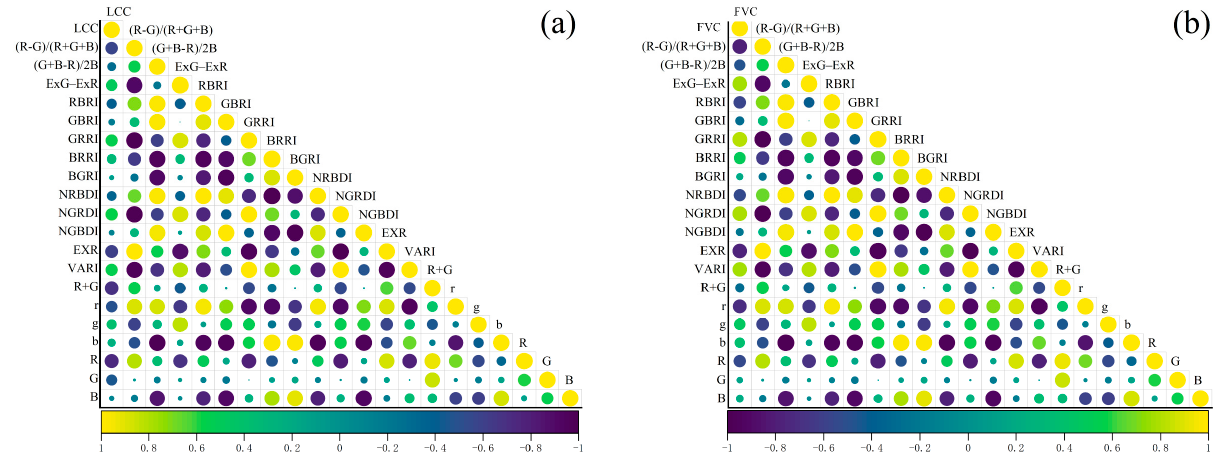
Figure 6. Pearson correlation coefficients between soybean LCC, FVC, and VIs: ( a ) LCC-Vis; ( b ) FVC-VIs.